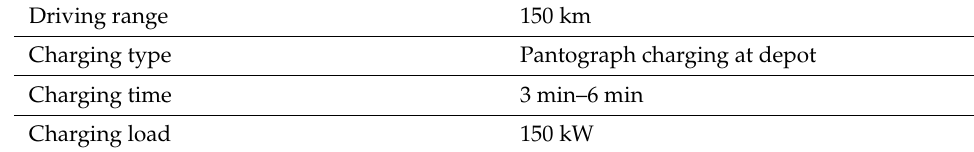
Table 3. e-bus specifications [50].